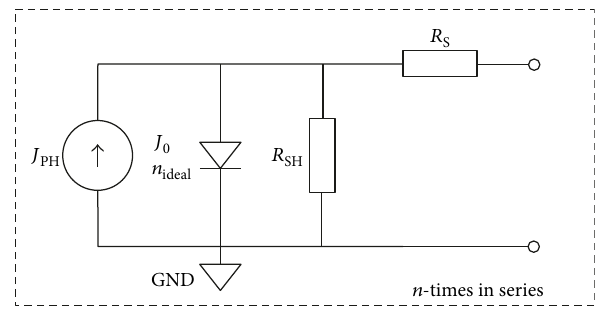
Figure 2: Elementary equivalent circuit of a solar cell. The components are series resistivity R S , shunt resistivity R SH , photo current J PH , saturation current J 0 , and ideality factor of solar cell n ideal . Table 1: Simulation data for the circuit shown in Figure 2. The simulation was repeated for an increasing number of cell partitions and for two di ff erent photocurrent densities. The series resistance is the sum of R C and R R